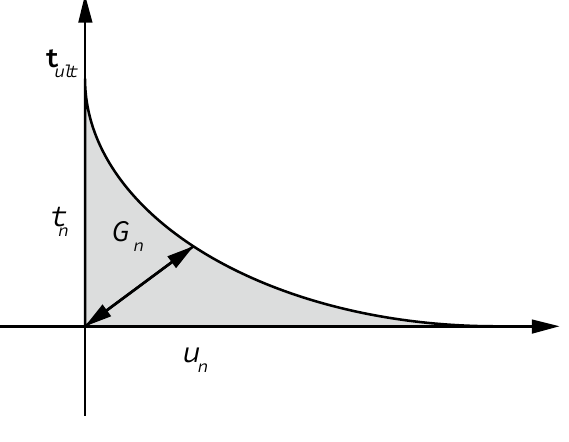
Figure 2. Cohesive softening